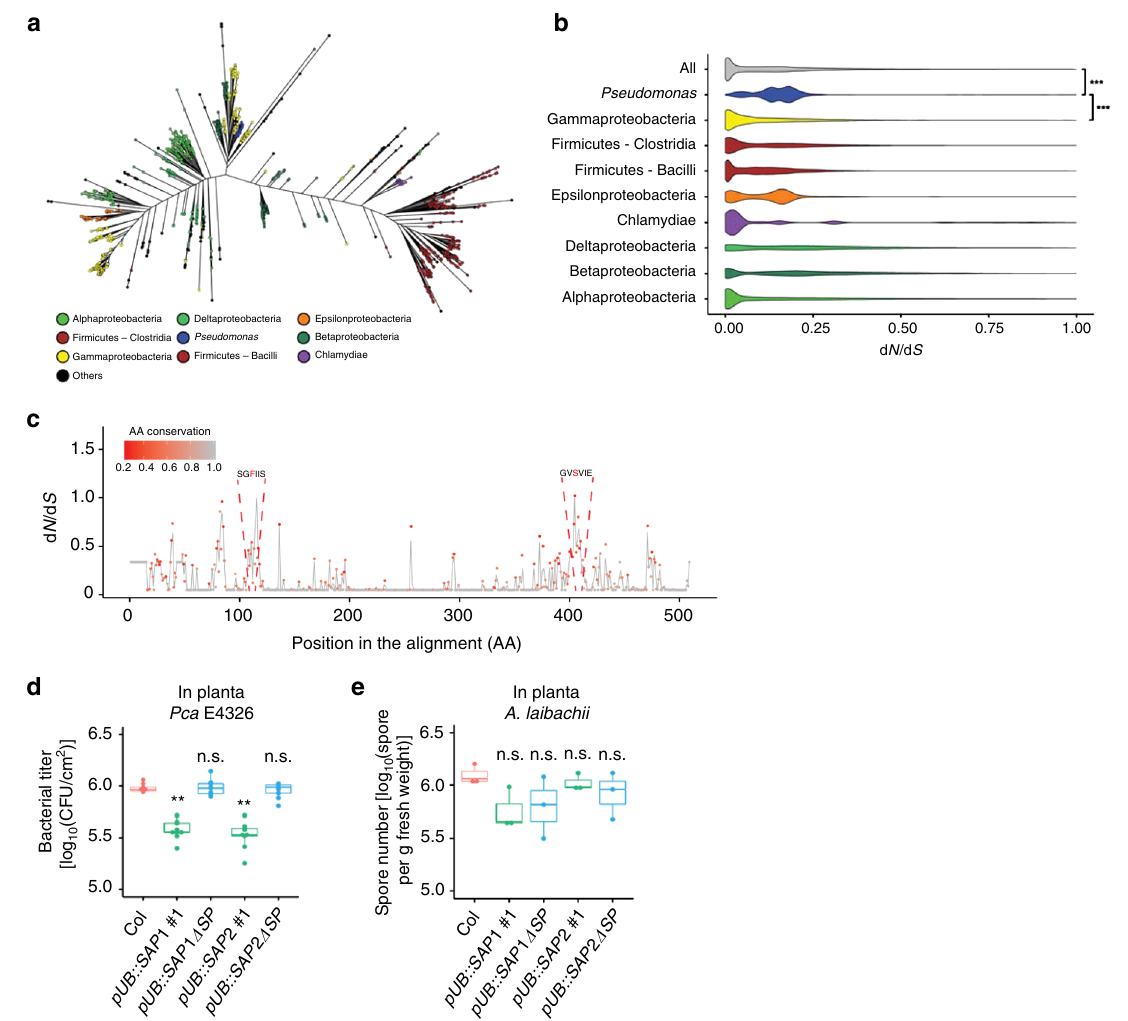
Fig. 5 MucD is evolutionarily conserved. a Maximum-likelihood tree of MucD sequences ( n = 2304). Colors correspond to the different taxonomic groups. b Violin plots showing distributions of pairwise d N /d S ratios for each major taxonomic lineage as well as for the entire dataset. Sequences found in the genomes of Pseudomonas were removed from the “ Gammaproteobacteria ” and the “ All ” groups and were tested for signi fi cantly enriched d N /d S ratios (Mann – Whitney test; *** P < 0.001). c Distribution of site-variable d N /d S ratios for the multiple sequence alignment of mucD sequences found in Pseudomonas genomes ( n = 92). The color scale corresponds to the amino acid conservation rate at each site. Putative aspartic protease cleavage sites are indicated in red. d Pca E4326 (OD 600 = 0.001) was in fi ltrated into leaves of 4-week-old Col, pUB::SAP1-RFP and pUB::SAP2-RFP plants, and bacterial titer was determined at 2 dpi. Bars represent means and s.e.m of three independent experiments with three biological replicates. Asterisks indicate signi fi cant differences from Col (Student ’ s two-tailed t test; ** P < 0.01). e Col, pUB::SAP1-RFP , and pUB::SAP2-RFP were infected with Albugo laibachii , and the number of spores was measured at 14 dpi. Bars represent means and s.e.m. of three independent biological Preparation of inocula and bacterial growth assay . Pto strains 58 were grown overnight in King ’ s B medium supplemented with 50 µg/ml of rifampicin and P. cannabina pv. alisalensis ES4326 was grown overnight in King ’ s B medium sup- plemented with 50 µg/ml of streptomycin. The bacteria were harvested by cen- trifugation, washed, and diluted to the desired density with sterile water. The bacterial growth assay was performed as described before 59 . Brie fl y, 4- to 5-week old leaves were syringe inoculated with bacterial suspension using a needleless syringe. A leaf disc collected from the in fi ltrated leaf was considered a biological replicate. In each experiment, six different plants were in fi ltrated.